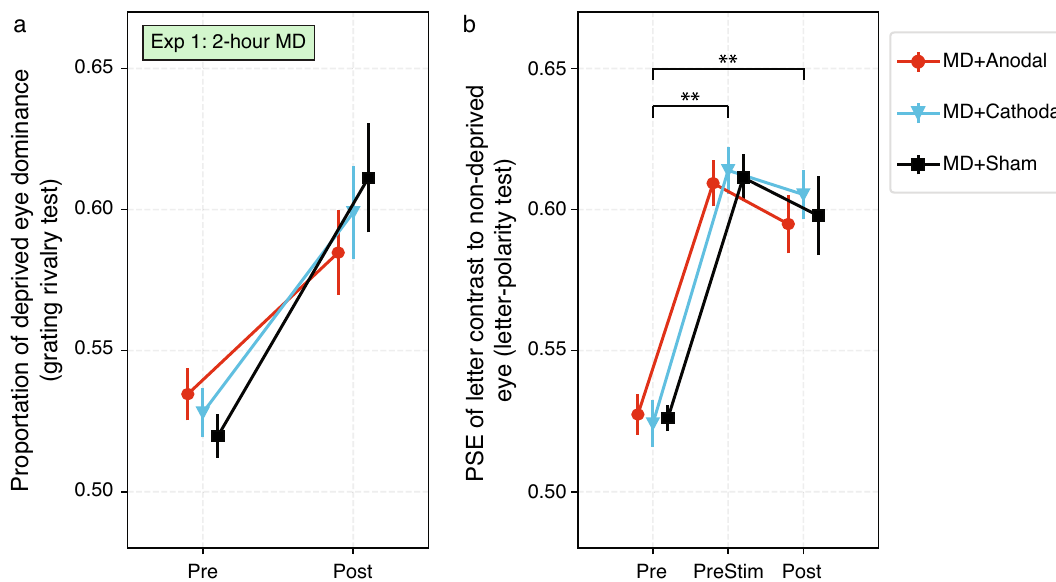
Figure 2. Deprived eye dominance at different time points for each tDCS condition in Experiment 1. ( a ) For the grating rivalry test, the proportion of deprived eye dominance is illustrated. Ocular dominance was measured at baseline (Pre) and immediately after MD (Post). ( b ) For the letter-polarity test, deprived eye dominance was indicated by the non-deprived eye letter contrast at the point of subjective equality (PSE). Ocular dominance was measured at baseline (Pre), 90 min after MD started (PreStim), and immediately after MD (Post). Ocular dominance > 0.5 indicates deprived eye dominance. Error bars represent standard errors of the mean. **Post hoc t tests p <